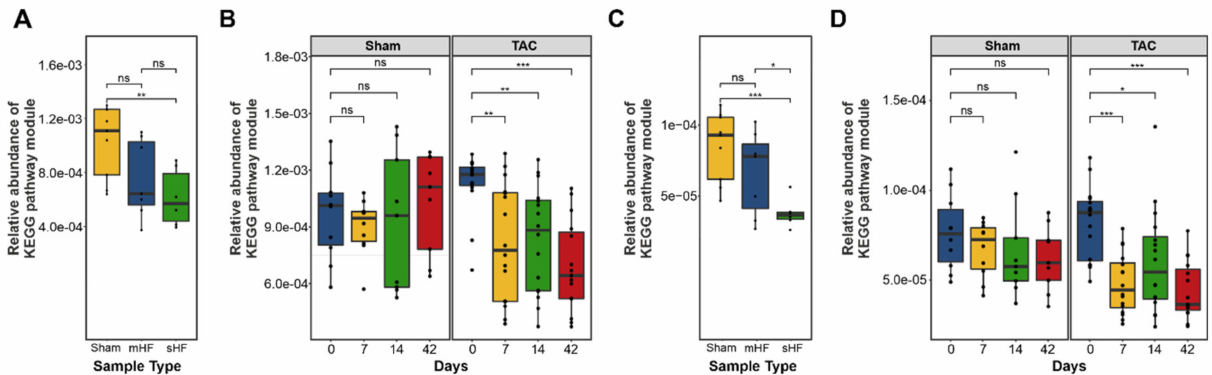
Figure 5. Box plot showing differences in the abundances of modules involved in butanoate and propanoate biosynthesis. ( A ) Differences in the abundances of genes involved in butanoate biosyn- thesis are shown for the sHF, mHF, and Sham samples. ( n values are as follows: Sham = 9, mHF = 7, sHF = 6). ( B ) Genes involved in butanoate metabolism in the Sham and TAC samples at differ- ent time points indicating a significant decrease in gene concentrations in TAC samples with